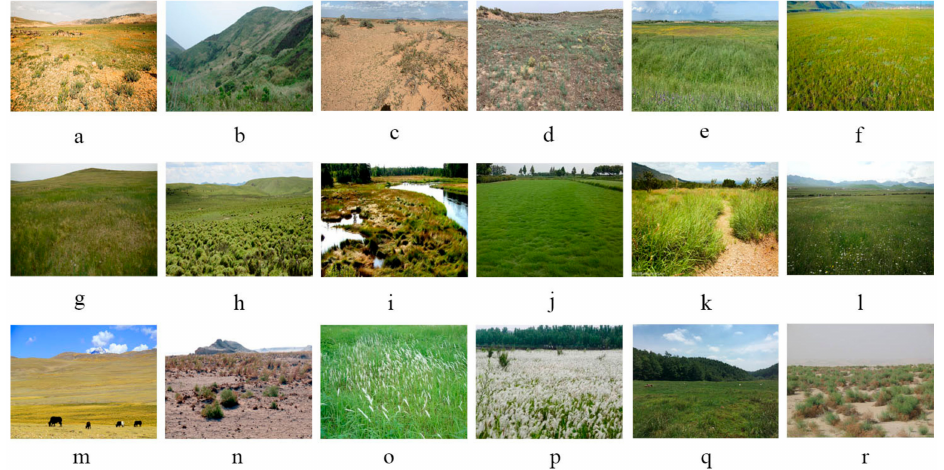
Figure 1. Grassland image data (examples): ( a ) alpine desert steppe, ( b ) mountain meadow, ( c ) tem- perate steppe desert, ( d ) temperate desert steppe, ( e ) temperate meadow steppe, ( f ) tropical tussock, ( g ) temperate steppe, ( h ) alpine meadow, ( i ) wetland, ( j ) lowland meadow, ( k ) savanna, ( l ) alpine meadow steppe, ( m ) alpine steppe, ( n ) alpine desert, ( o ) warm tussock, ( p ) warm shrub tussock, ( q ) tropical shrub tussock, and ( r ) temperate